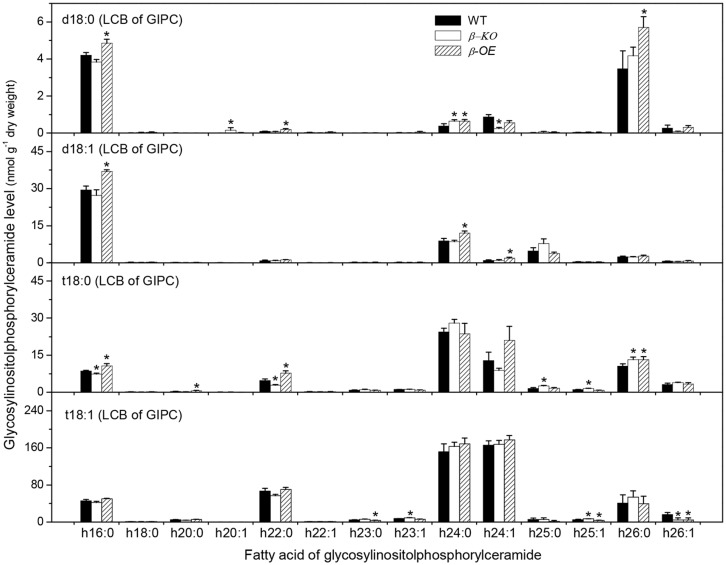
Levels of GIPC species in pPLAIIIβ-knockout and overexpression plant leaves. β-KO, T-DNA knockout of pPLAIIIβ (Salk_057212). β-OE, overexpression mutant of pPLAIIIβ driven by cauliflower mosaic 35S promoter. Values are means ± SE (n = 5). *Significant difference at P < 0.05 compared with the WT, based on Student’s t-test.